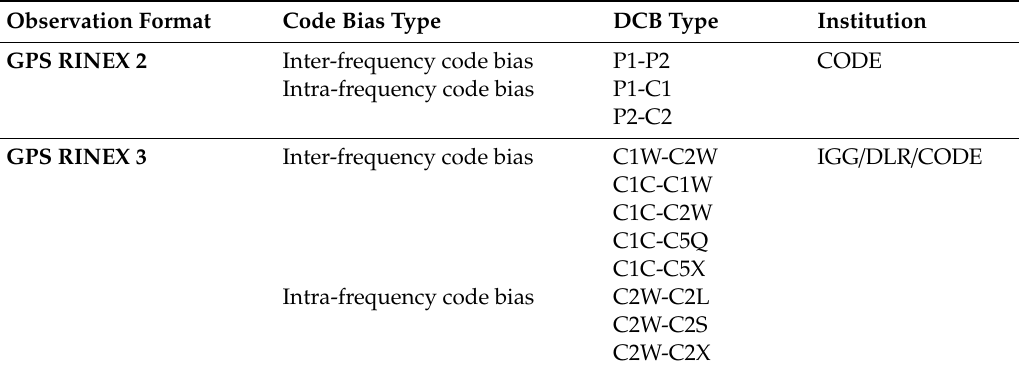
Table 1. Current code bias types for global position system (GPS)